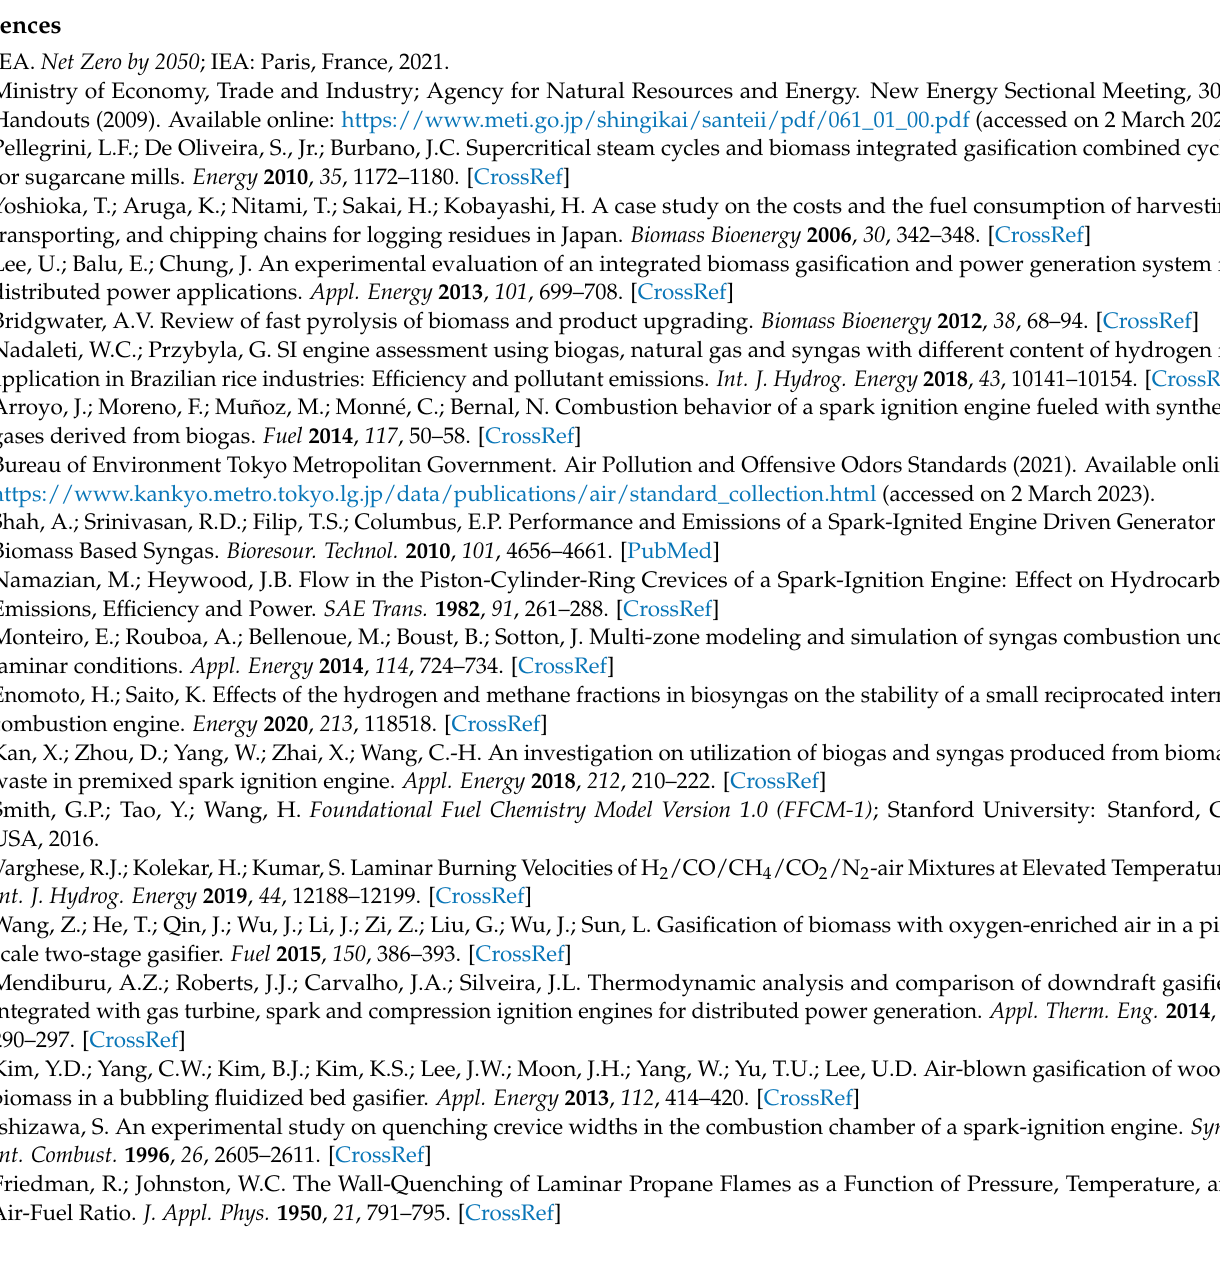
Figure S2: Definitions of calculation; Table S1: Physical properties. 13A is city gas (surrogate methane); Table S2: Range, accuracy and